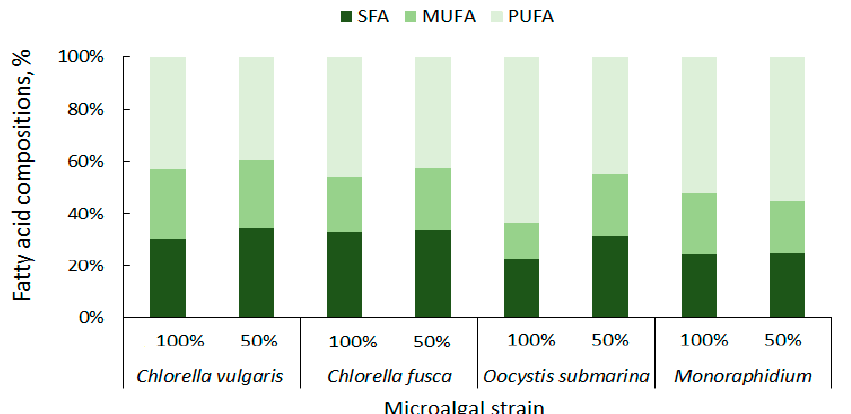
Figure 5. Summary composition of fatty acids in microalgal biomass.